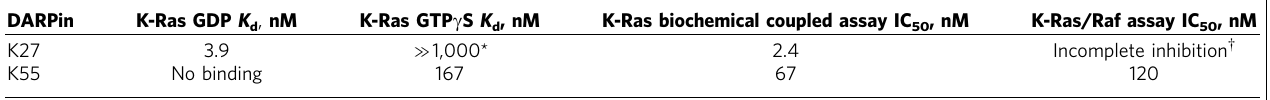
Table 1 | Activity of DARPins K27 and K55 in biochemical assays defines their mechanism of inhibition.